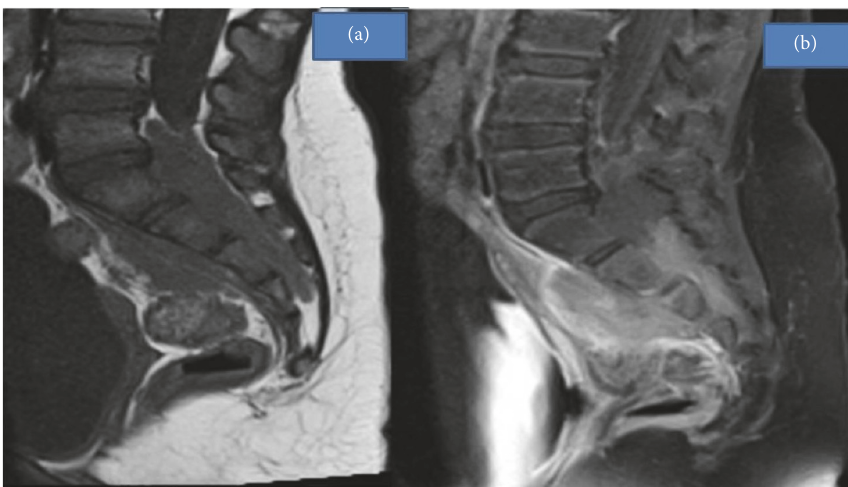
Figure 3: (a) Sagittal T1-weighted MRI shows a hypointense intracanalar and presacral infiltrating mass. (b) Postcontrast T1-weighted sagittal image with fat suppression shows heterogeneous enhancement of the mass and sacral vertebrae.